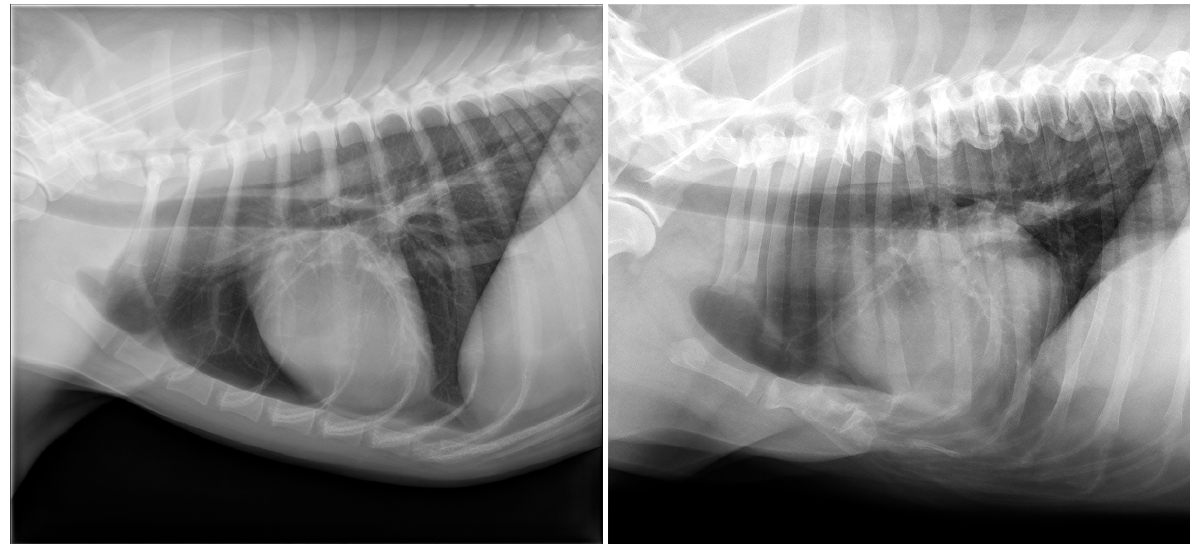
Figure 1. ( Left ) panel: Example of a left lateral radiograph of a dog with a sternum that was considered normal. ( Right ) panel: Abnormally short sternum in a 9-year-old, female neutered Bearded Collie. Caudad to the manubrium of the sternum, fusion of two to three shortened sternebrae with complete absence of the caudal part of the sternum is noted. The diaphragm shows cranial excursion, and the cardiac silhouette is mildly dorsally displaced. Vacuum phenomenon is visible between the manubrium of the sternum and second sternebra. Table 1. Radiographic findings and breeds per category of sternal abnormality in